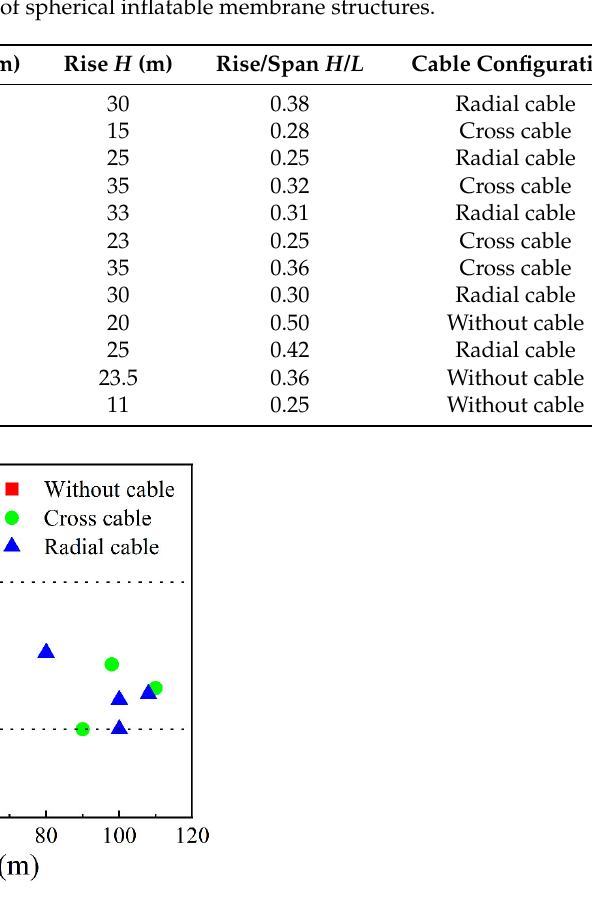
Table 1. Engineering information of spherical inflatable membrane structures.